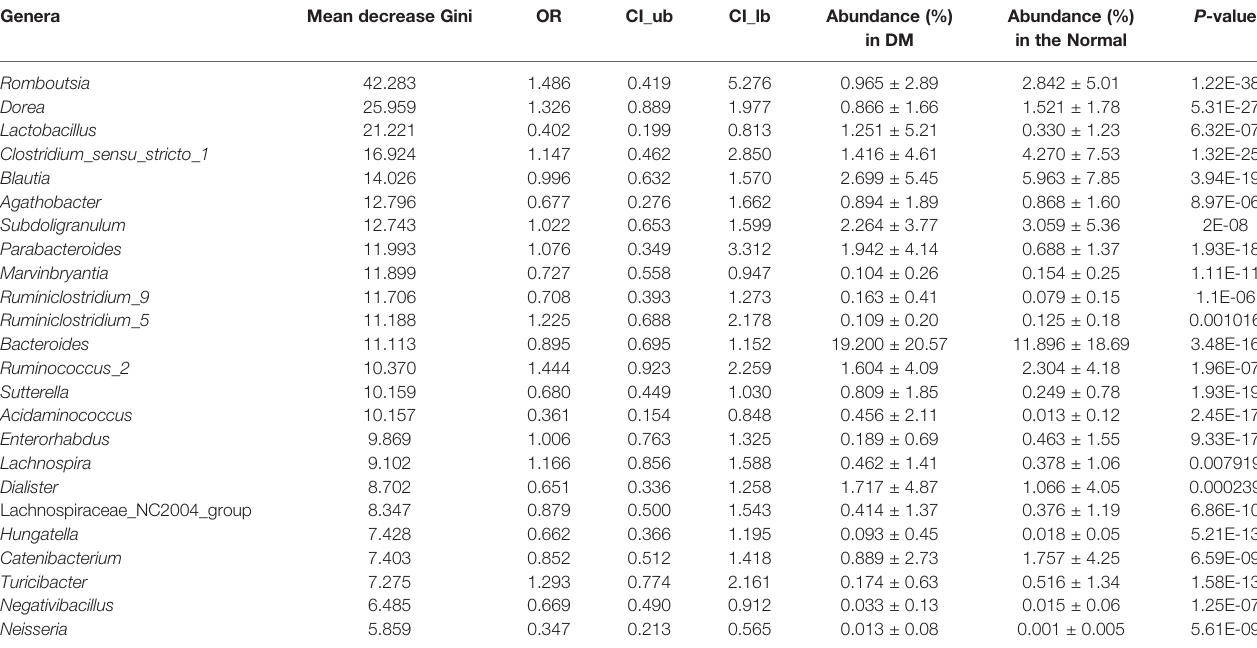
TABLE 2 | Importance, odd ration, con fi dence interval, and relative abundance of the 24 genera selected for the RF model for T2DM based on all samples.